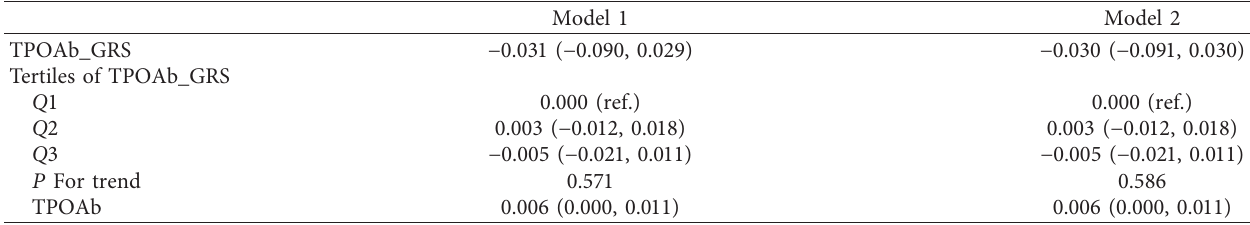
Table 6: Associations of TPOAb_GRS and TPOAb concentration with 25 (OH)